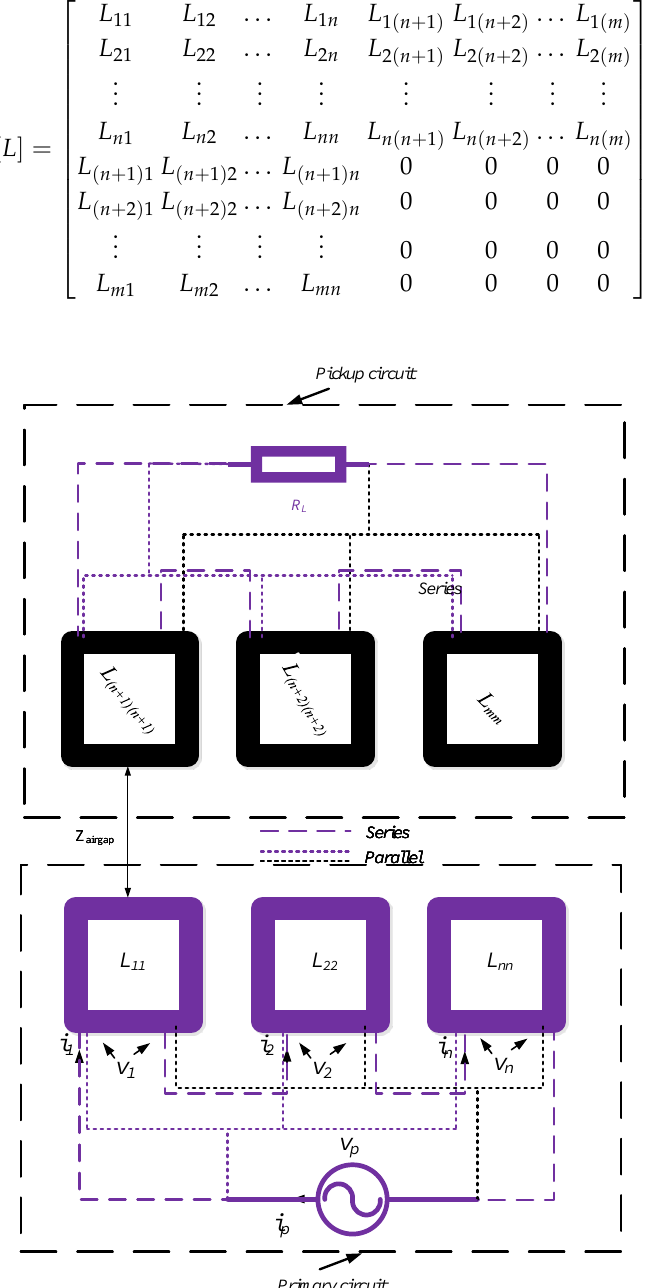
Figure 5. Defining an inductive power transfer (IPT) system with the primary and secondary composed of multiple coils with self-inductances as ( L ij , i = j ) and mutual inductances as ( L ij , i (cid:54) = j ) . The series and parallel combination can now be decomposed from this multi-coil